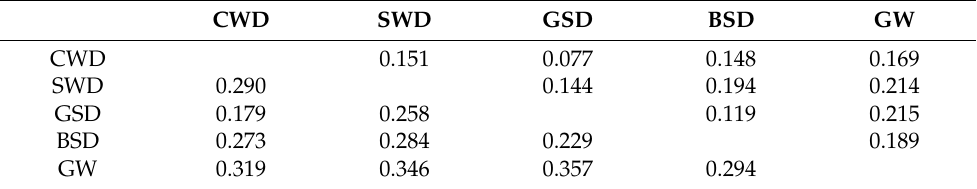
Table 3. Genetic distance matrix among breeds analysed based on Wright’s F ST index (under diagonal) and Nei’s genetic distances (above